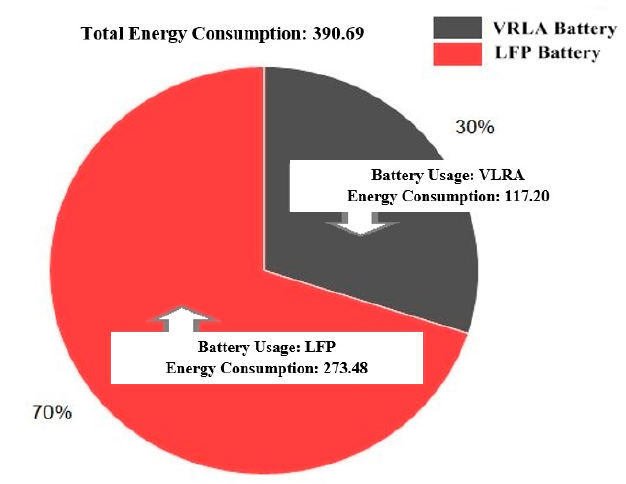
Figure 24. Energy consumption graph in dual hybrid battery testing. Table 4. Comparison of battery energy use and energy savings.